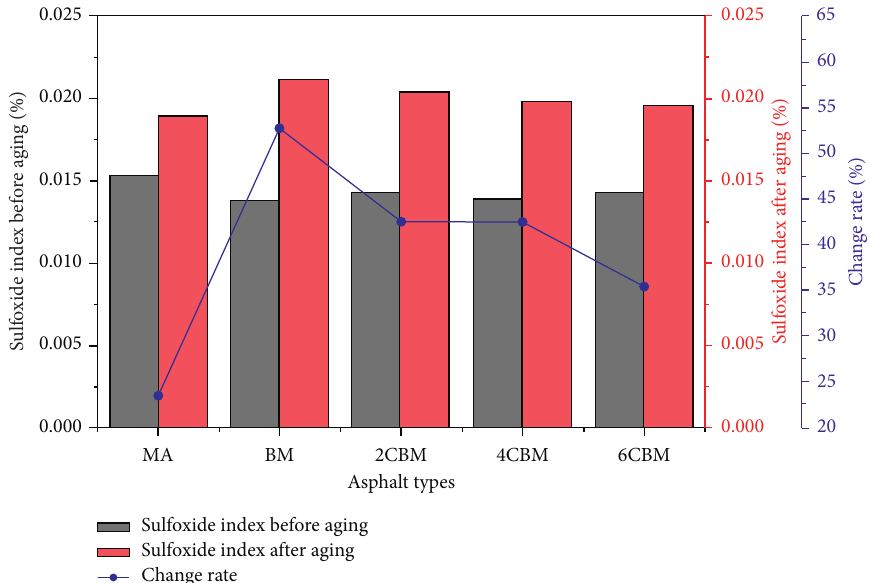
Figure 11: Effect of organic nano-CaCO 3 on sulfoxide index (SI) of bioasphalt before and after